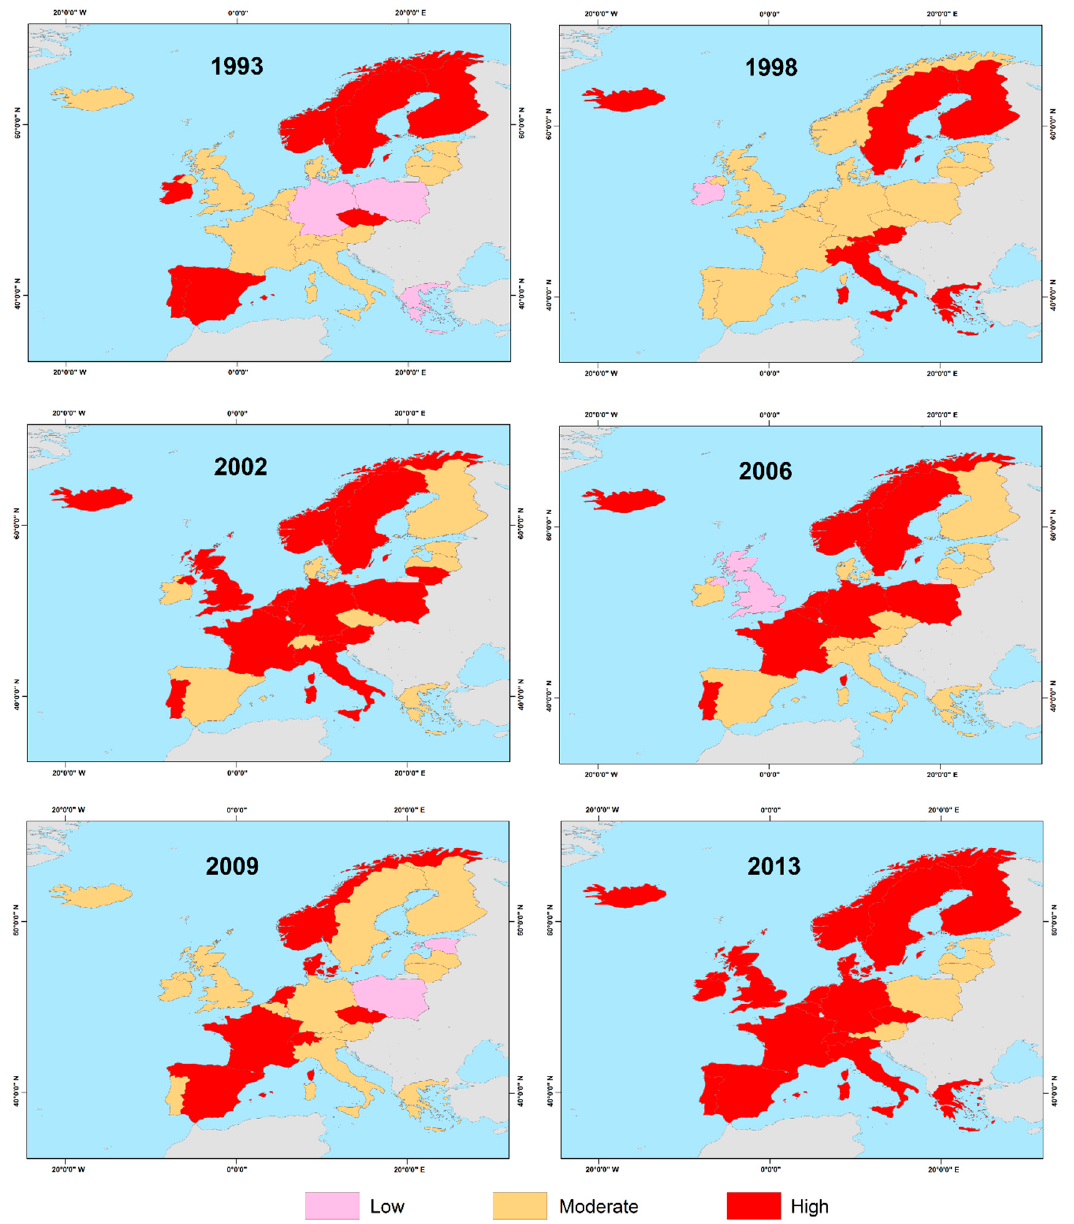
Figure 7. Population aging (parameter ξ ) for female gender in 1993, 1998, 2002, 2006, 2009, and 2013.